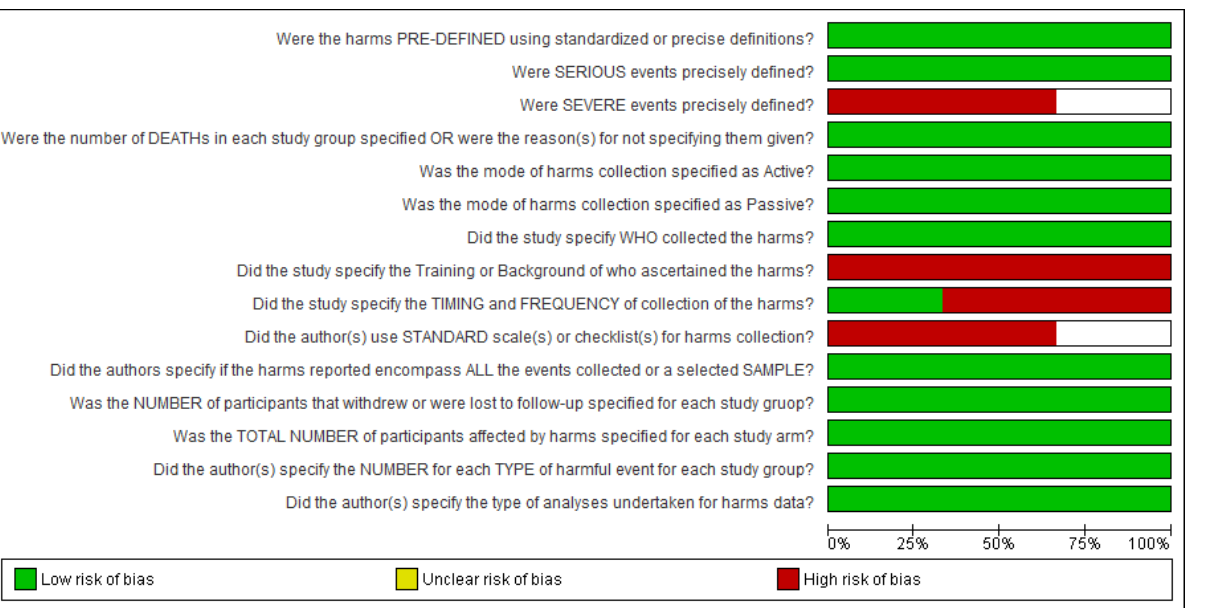
figure 2 - Risk of bias graph: review authors’ judgements about each risk of bias item presented as percentages across all included